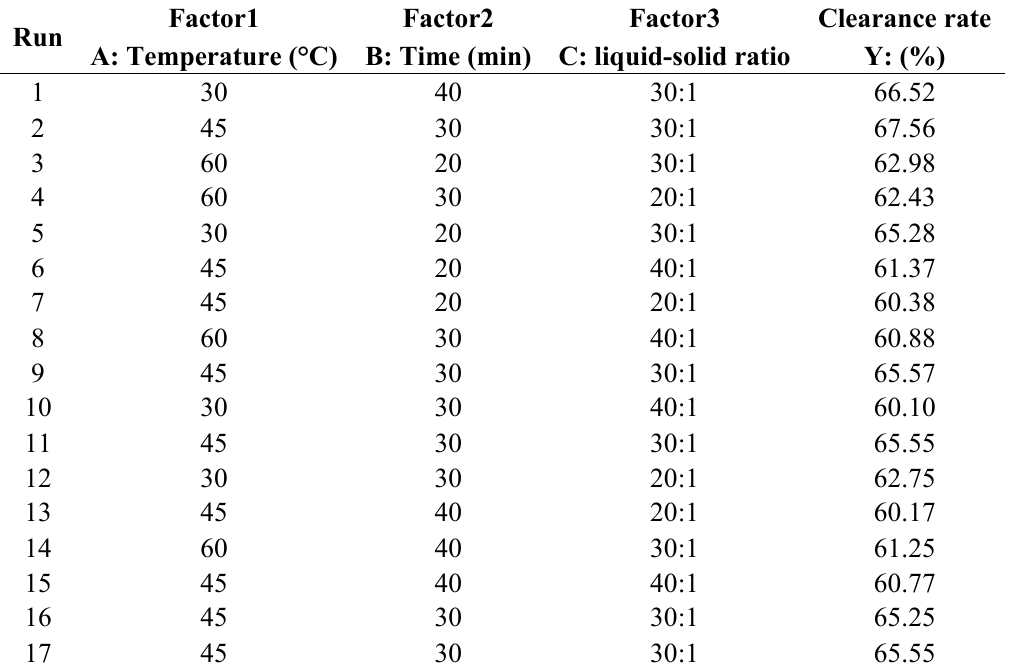
Table 1. Response surface analysis program and results for black beans sprout